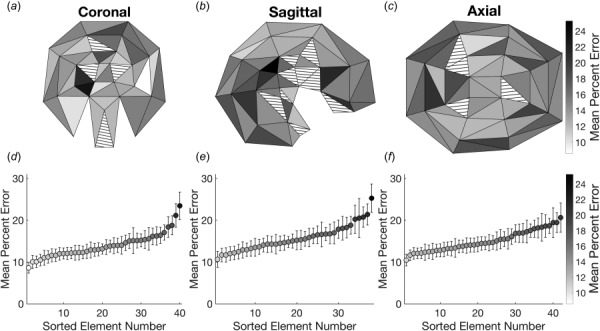
ML-assisted MBMs to predict regional MPS. Machine learning performance in the (a) coronal, (b) sagittal, and (c) axial planes. Triangular elements are shaded according to the mean percent relative error. Striped regions were not trained with ML models. (d)–(f) The average absolute relative error in predicted MPS for regions in each plane.